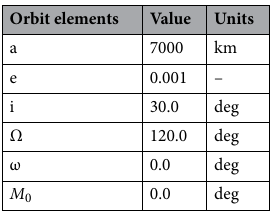
Table 2. Parameter of the orbit